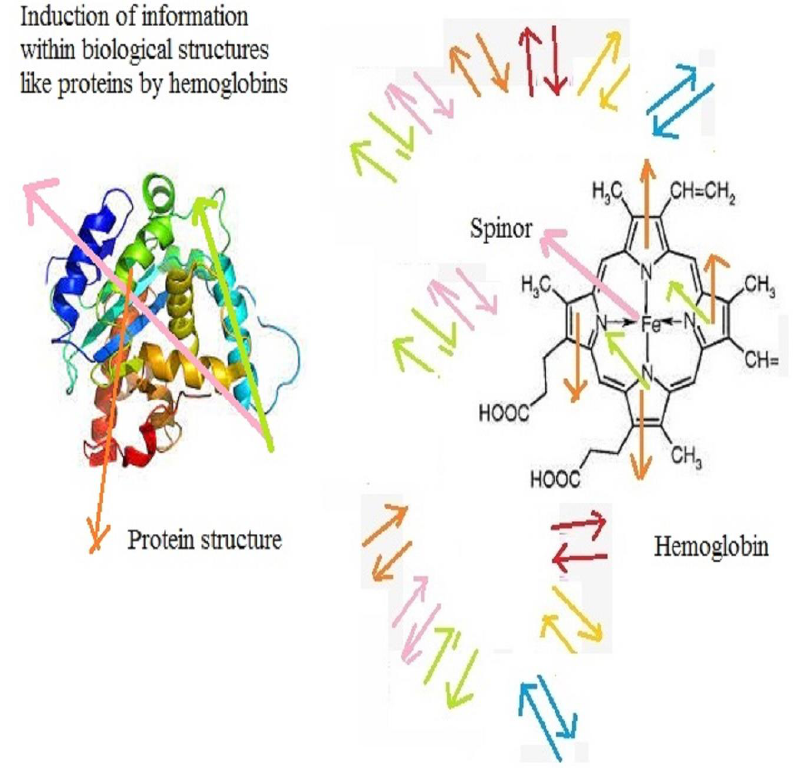
Figure 5. Induction of information into DNA bases by hemoglobin—a hypothesis.